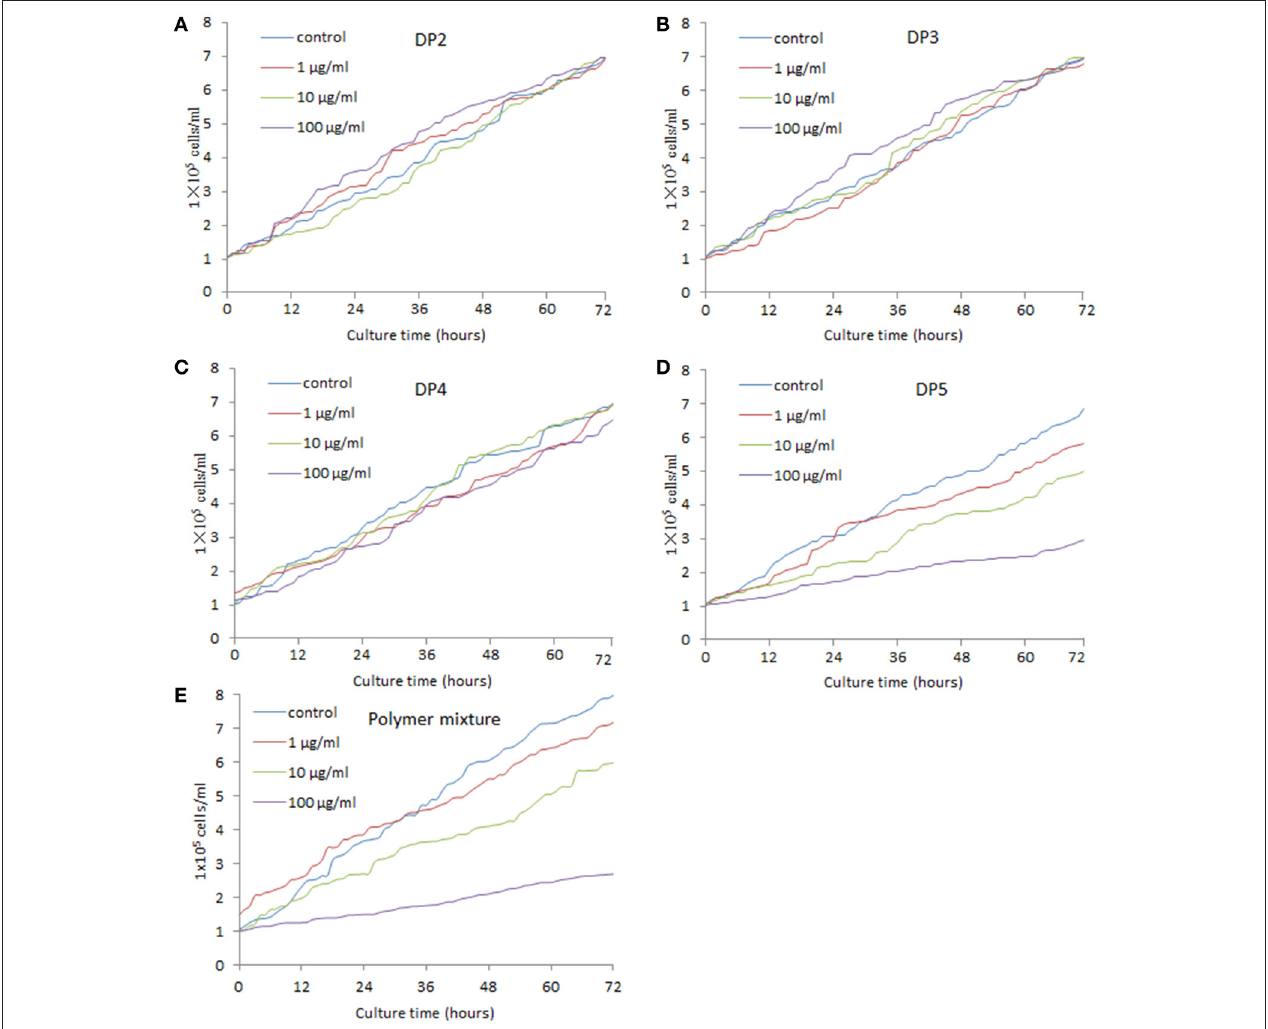
FIGURE 3 | Real-time analysis for the effects of AOS on the growth of MG-63 osteosarcoma cells. (A) The effects of AOS DP2 on the growth of MG-63 cells. (B) The effects of AOS DP3 on the growth of MG-63 cells. (C) The effects of AOS DP4 on the growth of MG-63 cells. (D) The effects of AOS DP5 on the growth of MG-63 cells. (E) The effects of polymer mixture on the growth of MG-63